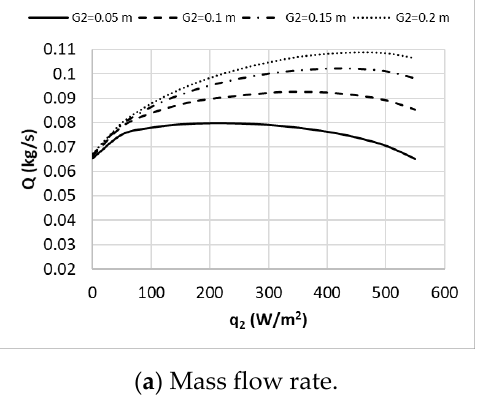
2 for Configuration